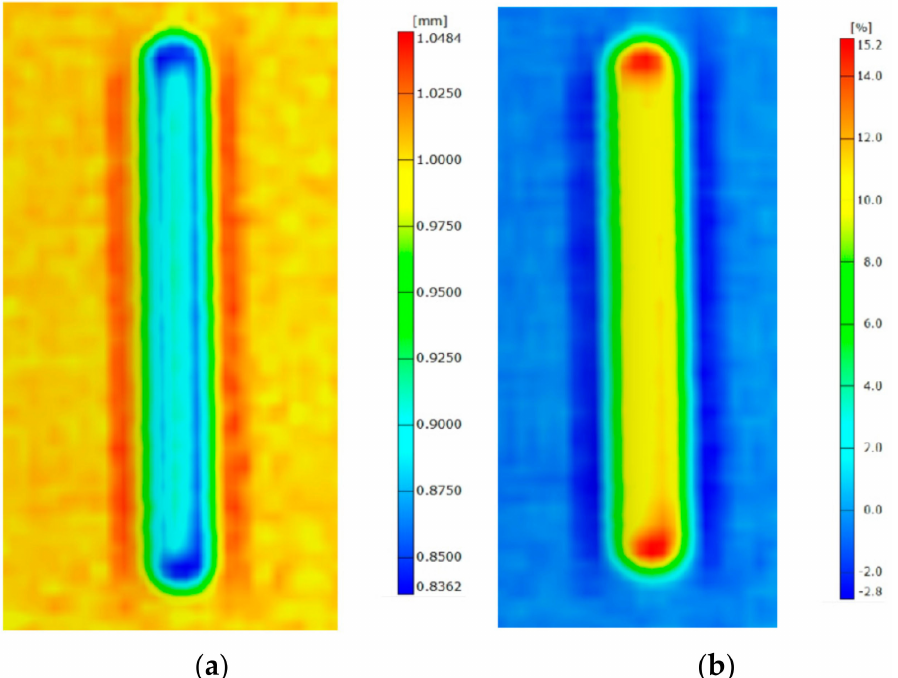
Figure 16. Distributions of ( a ) thickness and of ( b ) thinning of the rib fabricated in 1-mm-thick EN